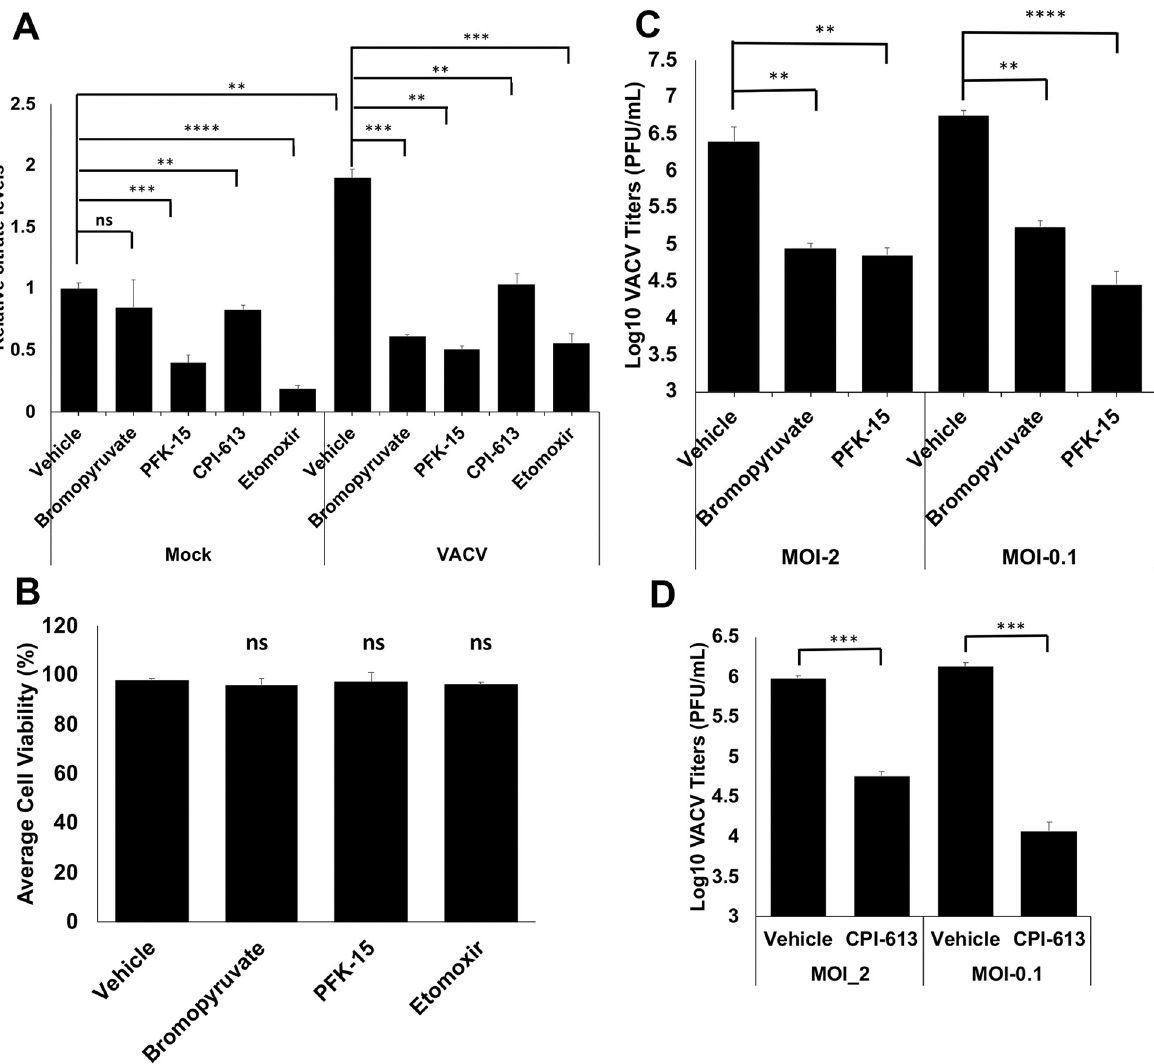
Fig 4. Both Glycolysis and β -oxidation contribute towards the citrate level enhancement during VACV infection. (A) Inhibition of glycolysis and fatty acid oxidation reduces the increase of citrate levels during VACV infection. HFFs were mock-infected or infected with WT-VACV at an MOI of 5 in medium with glucose plus glutamine in the presence or absence of 50 μΜ bromopyruvate, 50 μ M PFK-15, 100 μΜ of CPI-613, and 50 μΜ etomoxir. Citrate levels measured at 4 hpi using a citrate assay kit. (B) HFFs treated with indicated chemicals at a concentration as listed in Fig 4A in medium with glucose plus glutamine. Cell viability measured by a trypan blue assay at 48 h post treatment. (C) Glycolysis inhibition suppresses VACV replication. HFFs infected with WT VACV at an MOI of 2 (for 24 h) or MOI of 0.1 (for 48 h) in medium with glucose plus glutamine with or without 50 μΜ bromopyruvate, 50 μ M PFK-15. Virus titers measured by a plaque assay. (D) Inhibition of pyruvate dehydrogenase and α -ketoglutarate dehydrogenase reduces VACV titers. HFFs infected with WT VACV at an MOI of 2 (for 24 h) or MOI of 0.1 (for 48 h) in medium with glucose plus glutamine in the presence or absence of 100 μΜ CPI-613. Virus titers were measured by a plaque assay. Error bars represent the standard deviation of at least three biological replicates. ns, P > 0.05; �� , P � 0.01; ��� , P � 0.001; ���� , P � 0.0001.